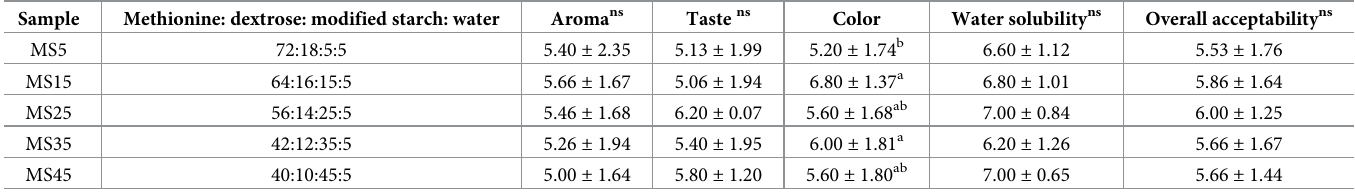
The temperature in zones 1, 2 was controlled at 100, 120˚C with a screw speed of 30 rpm. Means ± SD in the same column, followed by the same letter, are not significantly different at p < 0.05. ns: Not significantly different at p <